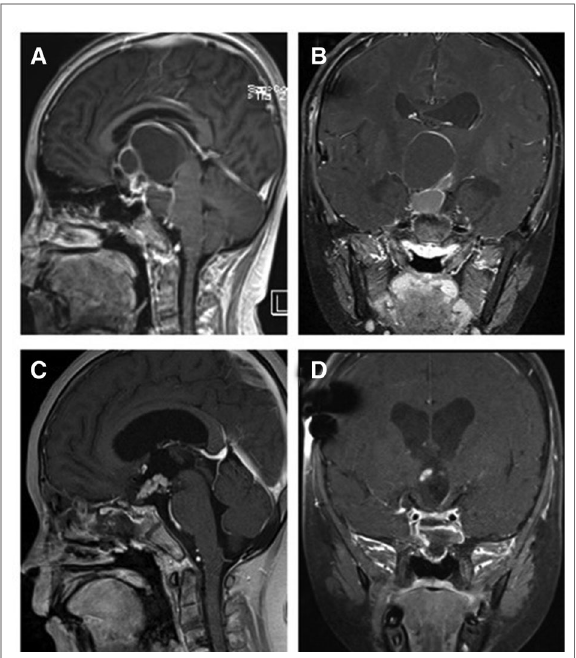
FIGURE 6 T1-weighted MRI image with contrast enhancement of suprasellar craniopharyngioma. ( A ) Preoperative sagittal view. ( B ) Preoperative coronal view. ( C ) Postoperative sagittal view. ( D ) Postoperative coronal view. Note in ( C ) and ( D ) the autologous fat employed intradurally to fi ll empty space within the sellar after tumor